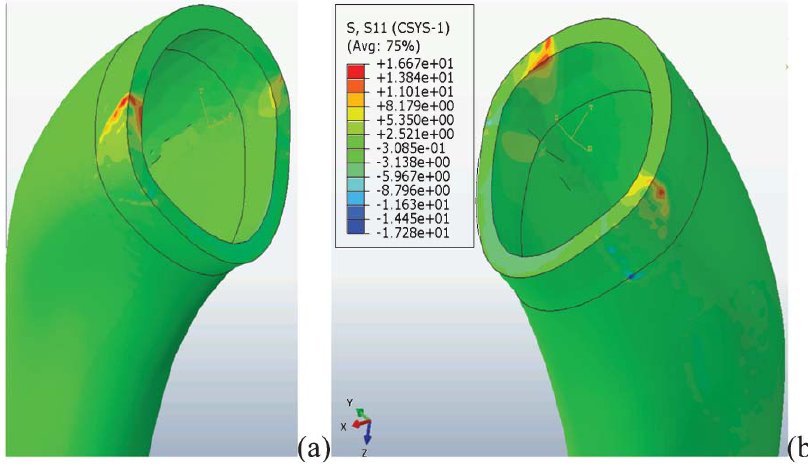
Fig. 11. (a) Right view and (b) left view of the radial stress (MPa) distribution in the cement mantle. The red color indicates the highest tensile stress. (Colours are visible in the online version of the article; http://dx.doi.org/10.3233/ABB-140097)